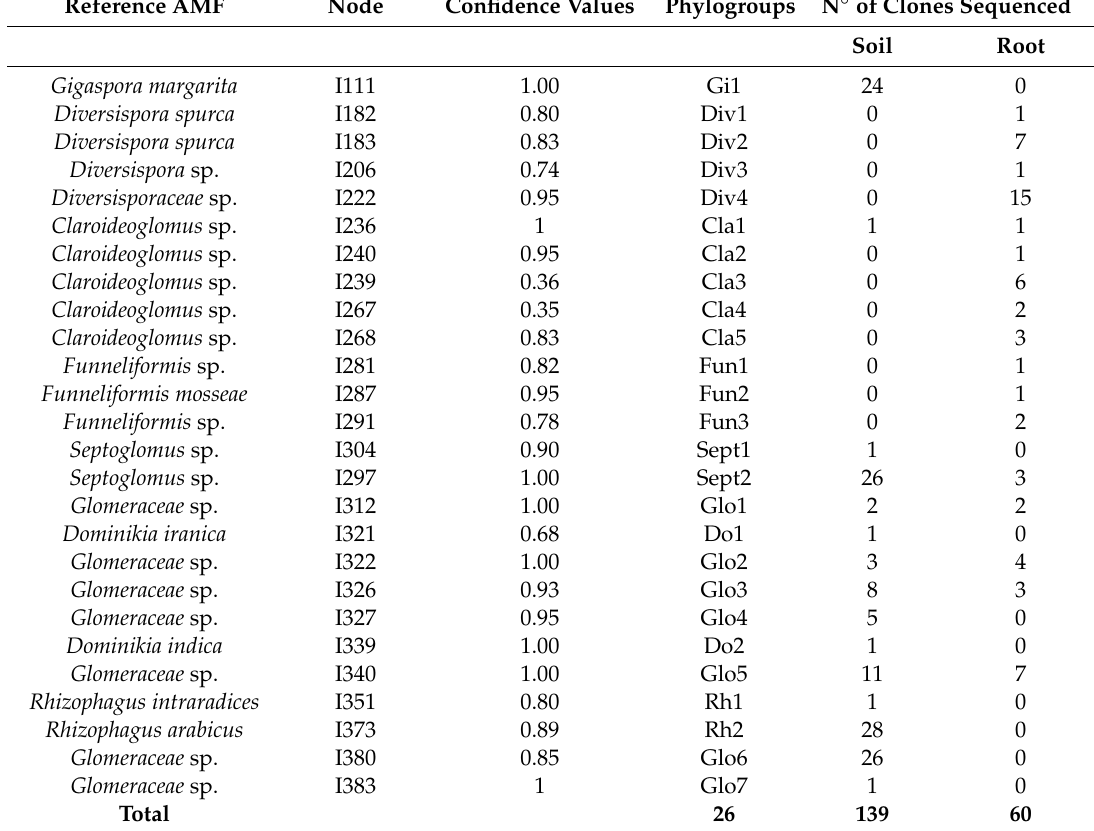
Table 1. Phylotypes of arbuscular mycorrhizal fungi, identified using the AML1–AML2 primer pair, in rhizosphere soils of L. ruthenicum , L. chinense , and S. salsa and in roots of the trap plant species L. ruthenicum , L. chinense , and P.